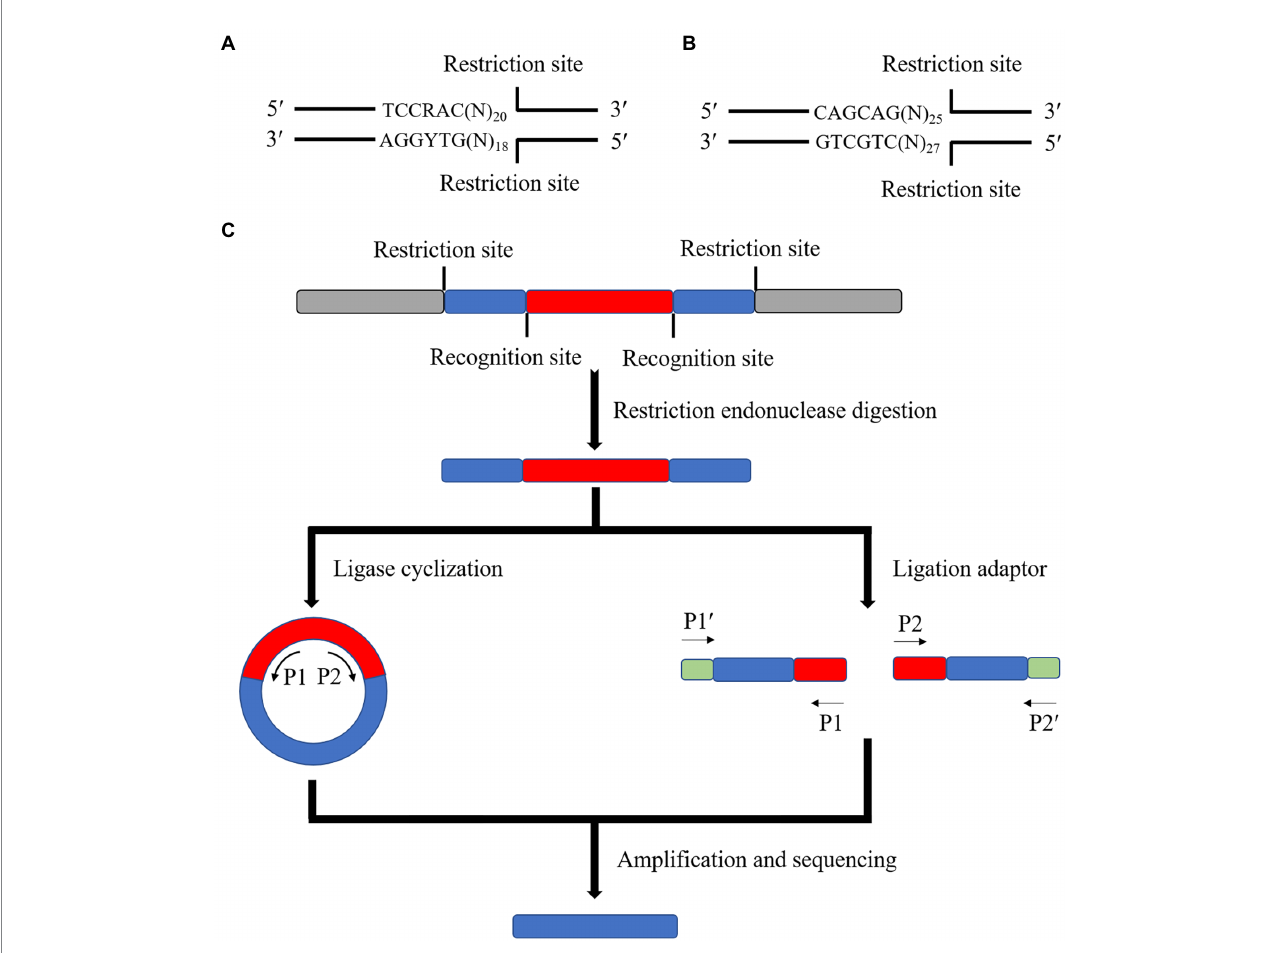
FIGURE 3 Schematic diagram of the principle of the special enzyme method. (A) Schematic diagram of the MmeI enzyme cleavage site (R is any purine, Y is any pyrimidine, N is any base). (B) Schematic diagram of the EcoP15I enzyme cleavage site. (C) The special enzyme cleavage method is to modify both ends of the transposon in advance and load the recognition site of a particular enzyme before transposition. After inserting the transposon into the target genome, the sequence of 18 ~ 27 bp is left on both sides of the fragment containing the transposon using a special enzyme cleavage. The ligase is cyclized or connected to the sequencing junction to amplify and sequence with the specific primer or junction sequence on the